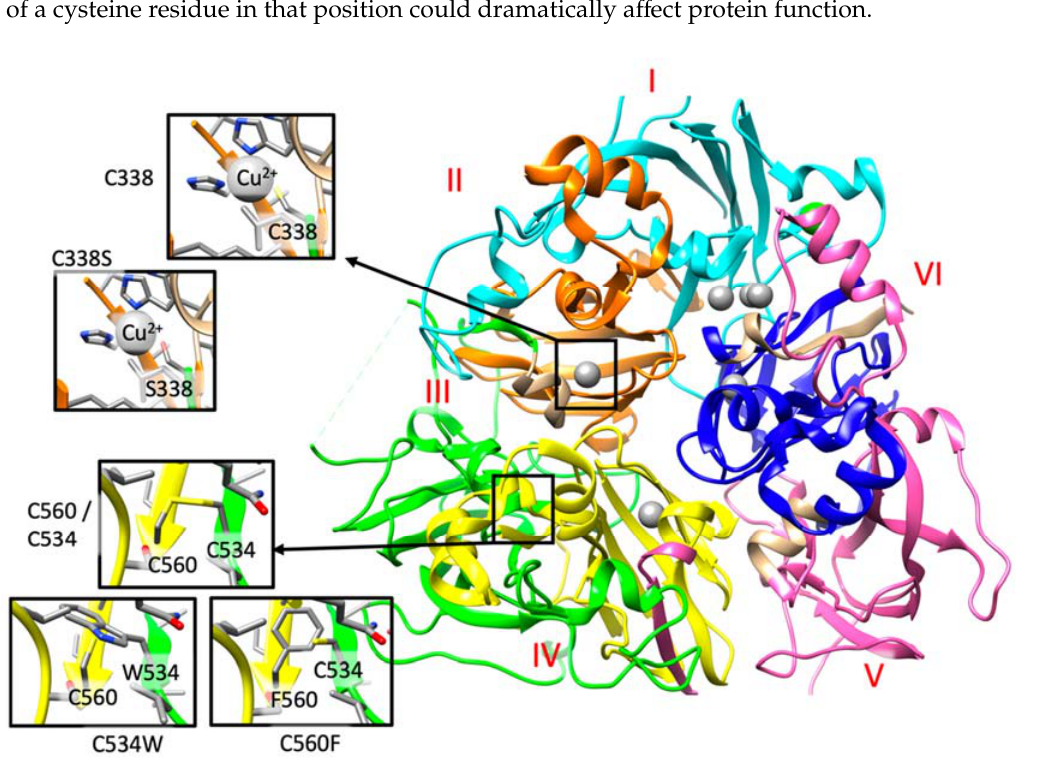
Figure 3. A. Detail of the structural analysis of selected missense mutations mapped on the structure of human ceruloplasmin (PDB code: 4ENZ). The reference and the mutated residue are indicated within the insights. The six Plastocyanin-like domains, described in the Uniprot Database (https: // www.uniprot.org / uniprot / P00450) I to VI are colored in cyan, orange, green, yellow, pink, and blue, respectively. Copper domains are colored in grey. These three variants, as well as those detailed in the main text, can be retrieved from the IronGenes database (http: // molsim.sci.univr.it / marchetto / php / gene_detail.php?geneId = CP#tabellaInit) developed at the University of